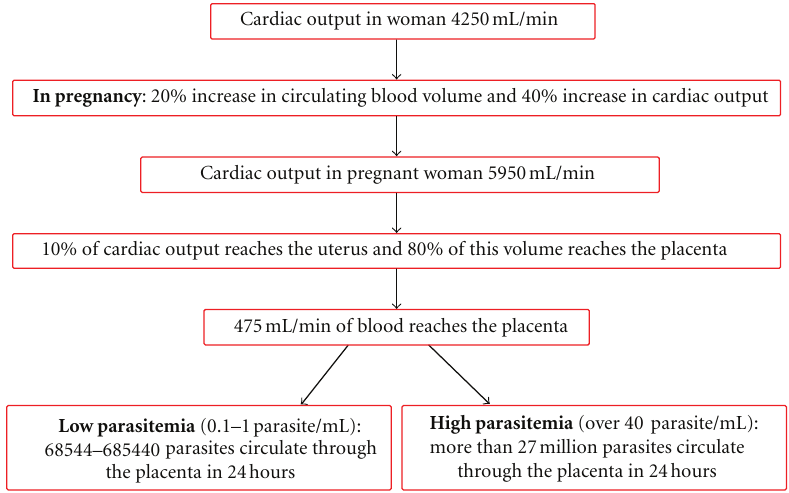
Figure 2: Estimation of T. cruzi contact with the placenta in infected